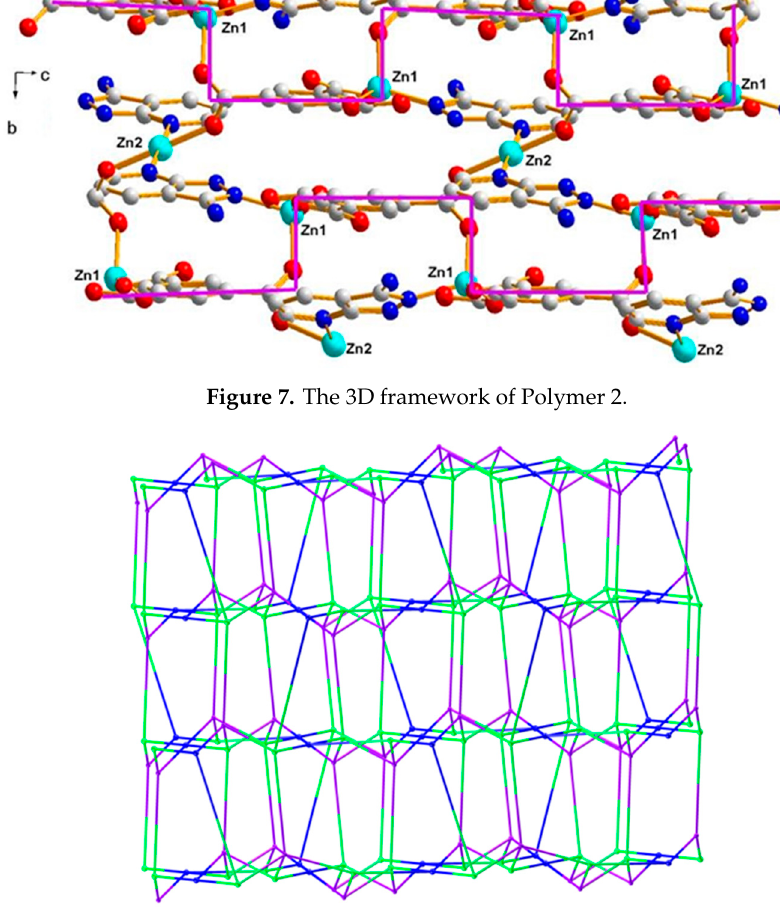
Figure 8. The 3D topological net of Polymer 2 (the blue, green, and purple spheres represent the nodes of Zn2(II), Zn1(II), and BTC 3 − , respectively).